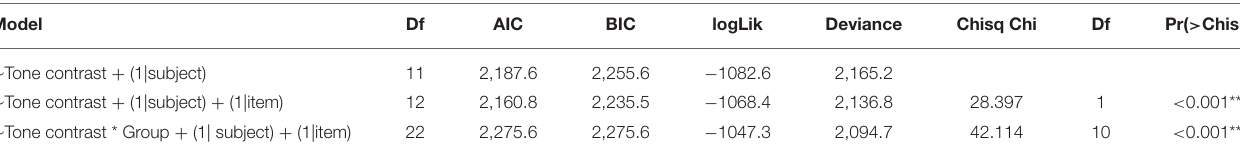
TABLE 3 | Results from the model comparison of the adult perception